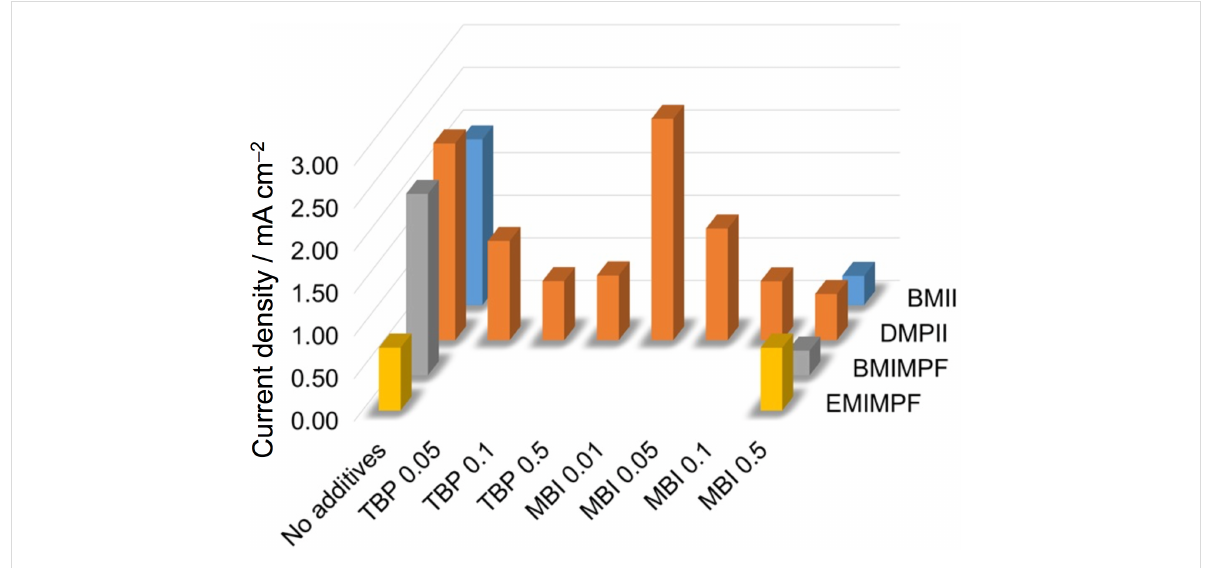
Figure 8: The dependence of short-circuit current density of the DSCs (on day of sealing the cells) on additives (concentrations in M). Electrolyte compositions are LiI (0.1 M), I 2 (0.05 M), ionic liquid (0.6 M) in MPN with additives as specified on the abscissa.